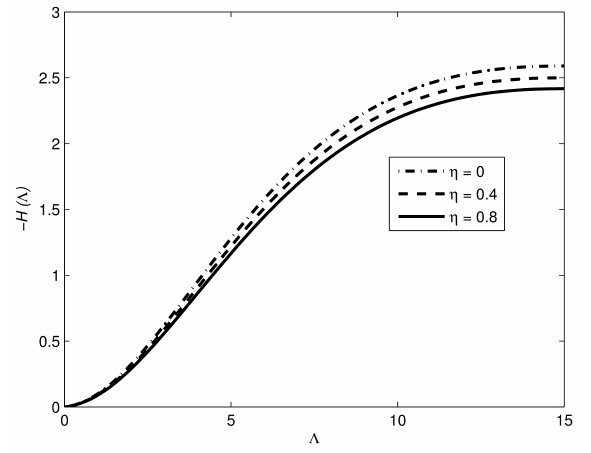
Figure 6: Effect of C 1 on − P ( Λ ) keeping ζ = η = 0.2 , C 2 = C 3 = 1 , Pr = 6.8 , Br = 1 and Re = 2950